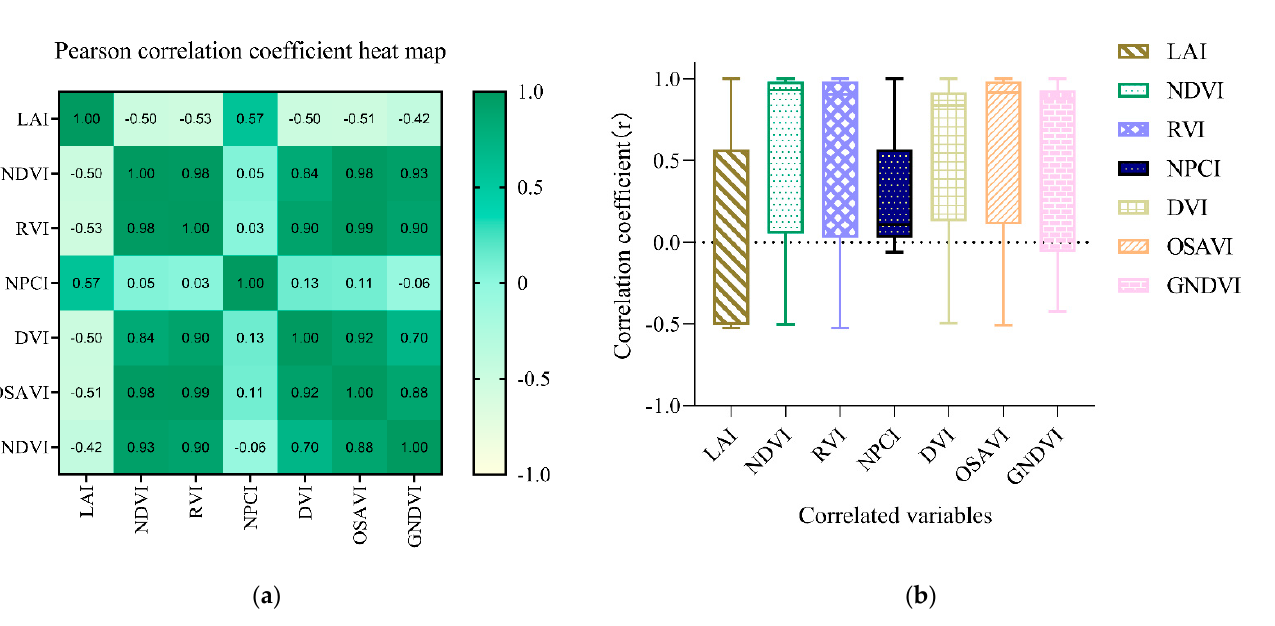
Figure 6. Box − and − whisker plots and heat maps of vegetation index and LAI correlation coefficients for the whole fertility period. The sample size of LAI was 120: ( a ) Heat maps of vegetation index; ( b ) box − and − whisker plots.